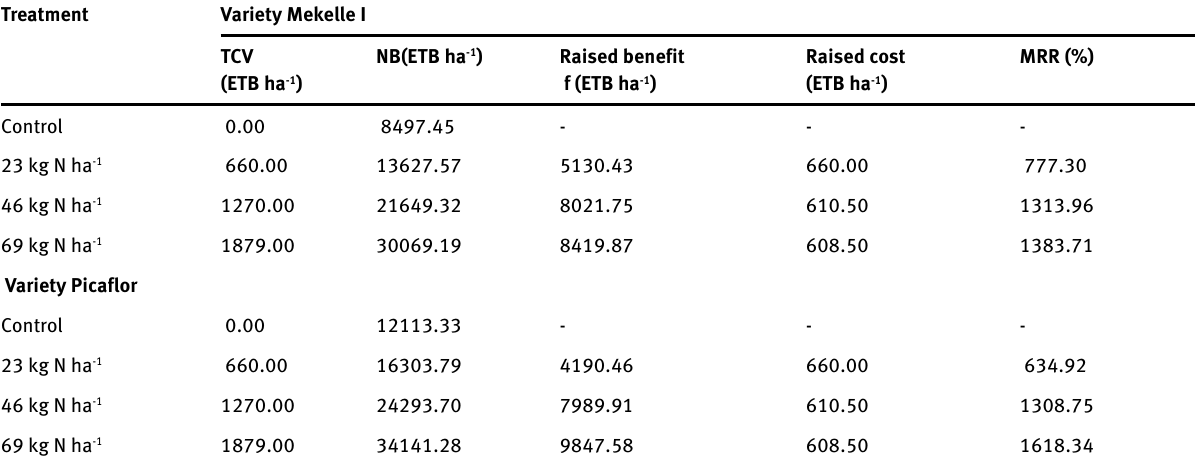
Table 5: Partial budget analysis on the effect of nitrogen fertilizer for the variety Mekelle I and Picaflor, Enderta, Tigray